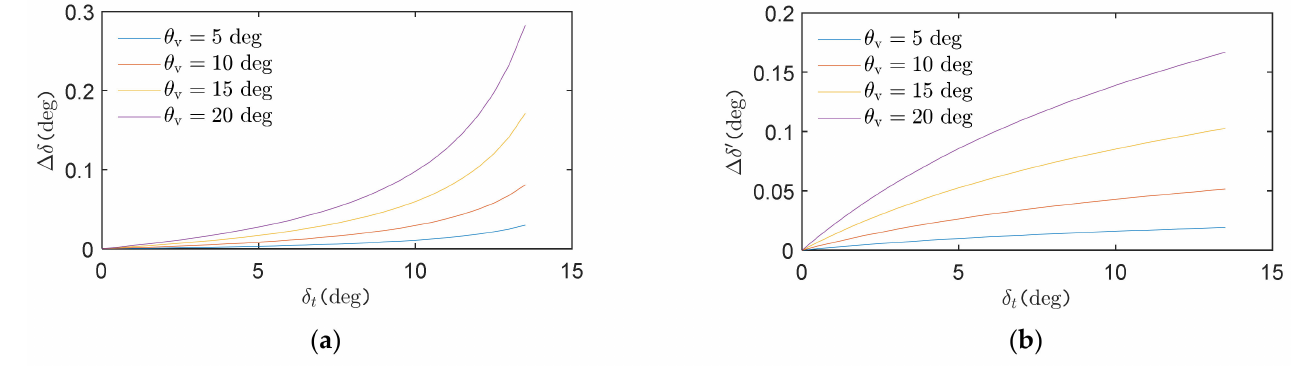
Figure 5. ∆ δ and ∆ δ (cid:48) represent the errors due to the tilting angle.